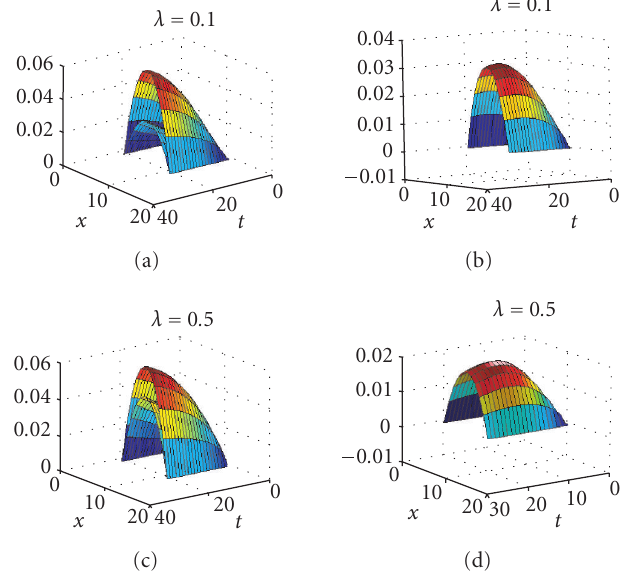
Figure 4.4. The upper solutions u ( x , t ) and v ( x , t ) and the di ff erence v ( x , t ) − u ( x , t ) for the slab ge- ometry, when β = 0 . 5, δ = 0 . 1, and λ = 0 . 1,0 . 5.